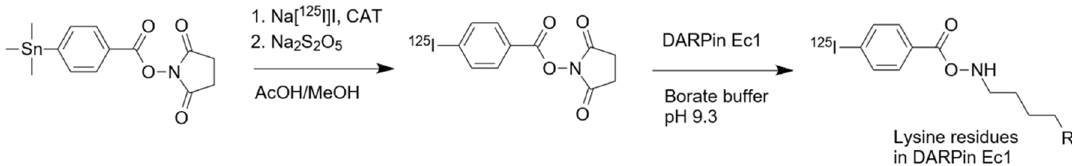
Figure 1. Radioiodination of designed ankyrin repeats protein (DARPin) Ec1 is a one-pot reaction achieved in two steps without intermediate purification. First, N-succinimidyl- para -(trimethylstannyl)benzoate is iodinated using Chloramine-T (CAT); in the second step, [ 125 I]- para -iodobenzoate ([ 125 I]I-PIB) is attached to lysine residues in DARPin Ec1.